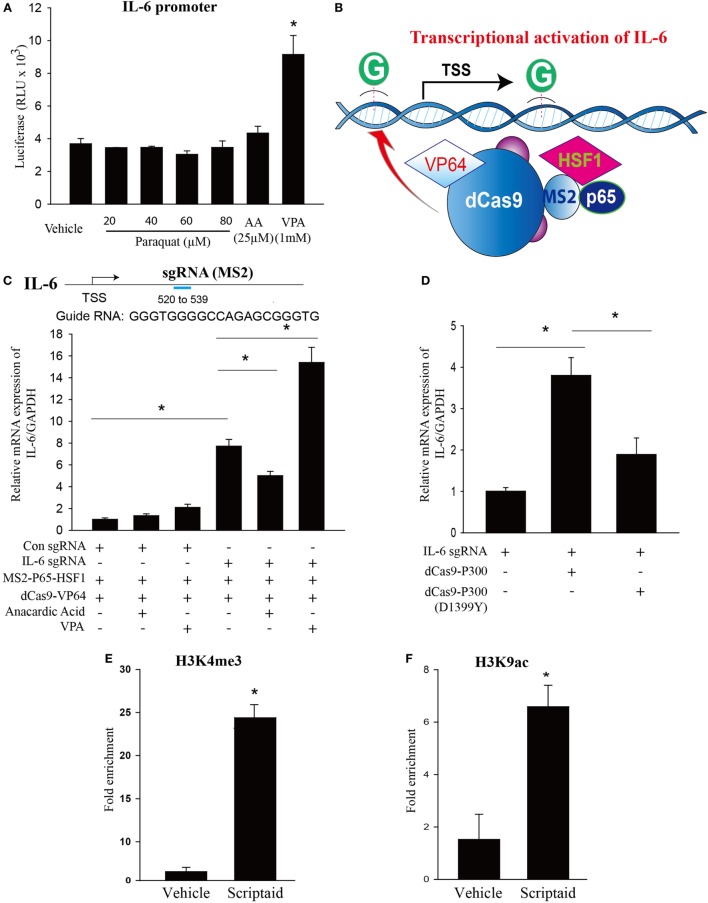
Modulation of endogenous IL-6 expression using CRISPR-ON, and the effects of histone deacetylase (HDAC) or histone acetyltransferase inhibition and epigenetic regulation of IL-6 transcription by HDAC inhibition. (A) HEK 293 T cells cotransfected with Firefly luciferase (LUC) reporter plasmids consisting of human IL-6 promoter and Renilla luciferase as a transfection control were treated with vehicle (DMSO), paraquat (20, 40, 60, and 80 μM), anacardic acid (25 µM), or VPA (1mM) for 24 h, and luciferase activity determined using a Polarstar Omega (BMG Labtech, Durham, NC, USA) luminometer. (B) Schematic of the CRISPR-ON strategy to activate IL-6 gene expression. (C) Guide RNA (gRNA) sequences and binding regions on the IL-6 promoters. HEK-293 cells were transfected with either a control gRNA or gRNA targeting the proximal IL-6 promoter regions in the presence or absence of VPA (1 mM) or anacardic acid (25 µM) for 24 h. (D) HEK-293 cells were co-transfected with IL-6 gRNA and dCas9-p300 or dCas9-p300 (D1399Y) plasmids. IL-6 mRNA levels were determined by real-time PCR relative to GAPDH. (E,F) Macrophages treated with vehicle (DMSO) or scriptaid (3 µg/ml) were fixed with 1% formaldehyde for 10 min and chromatin prepared by enzymatic shearing for 10 min. ChIP was performed on isolated sheared chromatin using a negative control IgG and ChIP grade antibodies to H3K4 trimethylation (H3K4me3) or H3K9 acetylation (H3K9ac). Real-time PCR was performed on DNA purified from each of the ChIP reactions using primers specific for the IL-6 promoter regions located upstream of IL-6 transcriptional start site. HEK 293 T cells were plated in 12-well plates at a density of 0.5–1 × 106 cells/well, and the data are representative of n > 5 from each group. Macrophages were plated in 100 mm dish at a density of 1–1.5 × 107 cells/dish, and the data are representative of n > 5 from each group. Data are expressed as means ± SEM, *P < 0.05 (n = 4–6).